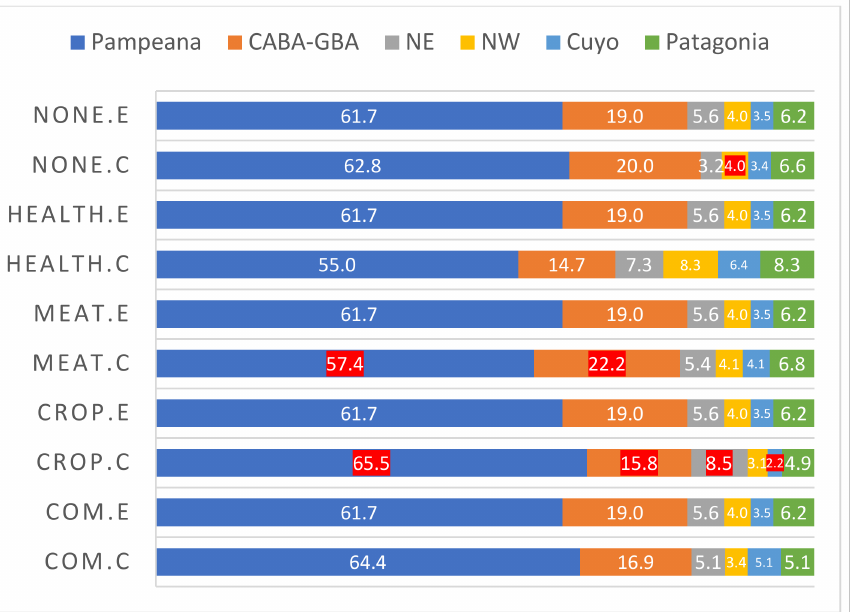
Figure 1. Counted and expected percentages for consumer occupation for each region. CABA-GBA: The metropolitan area, including Greater Buenos Aires. NE: Northeast region. NW: Northwest region. “E”—expected; “C”—counted. None—none of them. Health—human health. Meat—meat production. Crop—crop production. Com.- livestock or meat commercialization. Regions in which counted percentages differed from expected percentages are marked in